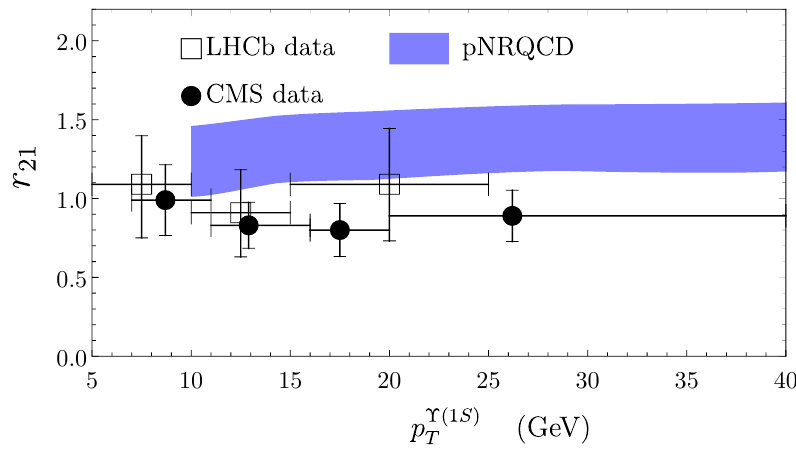
Figure 6 . Ratio of χ b 2 (1 P ) and χ b 1 (1 P ) differential cross sections at the LHC center of mass √ energy s = 7 TeV and in the rapidity range 2 < y < 4 . 5 compared with LHCb [59] and CMS [60]